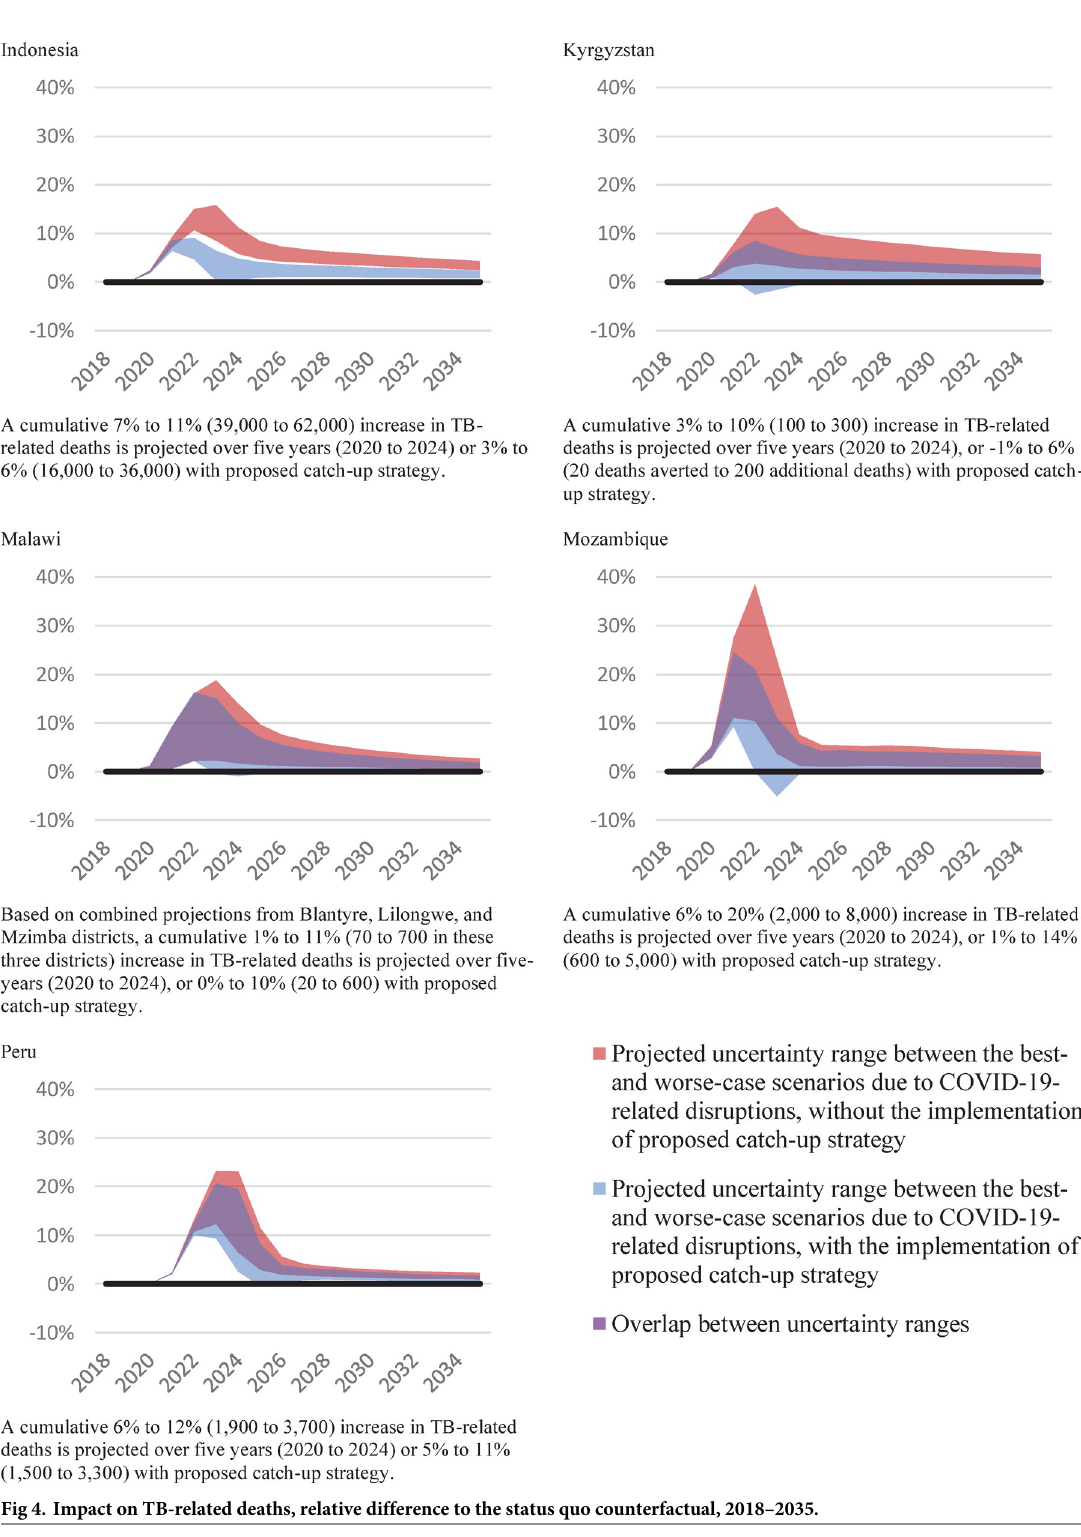
PLOS Global PublicHealth | https://doi.org/10.1371/journal.pgph.0000219 March 30,